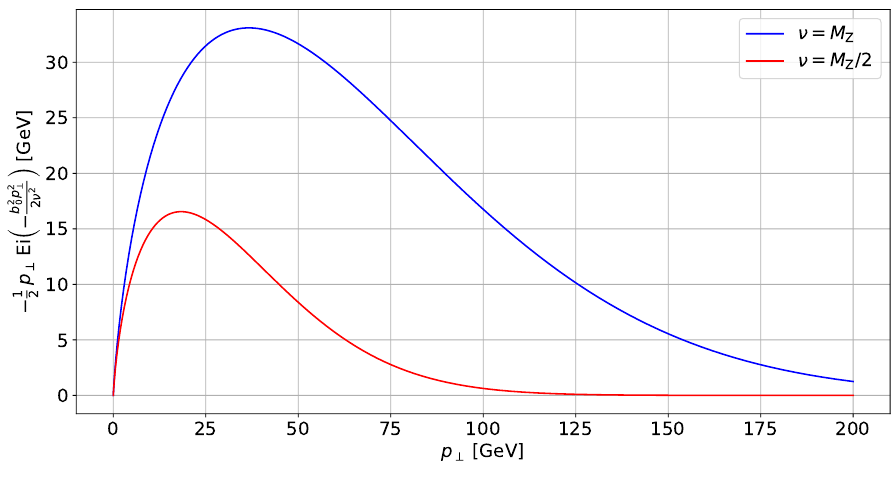
Figure 5 . p ? pro(cid:12)le of the subtraction term for (cid:23) = M Z and (cid:23) = M Z = 2. The area under each curve is equal to (cid:23) 2 = (2 b 2 ). Here, (cid:12) = 1 is 0